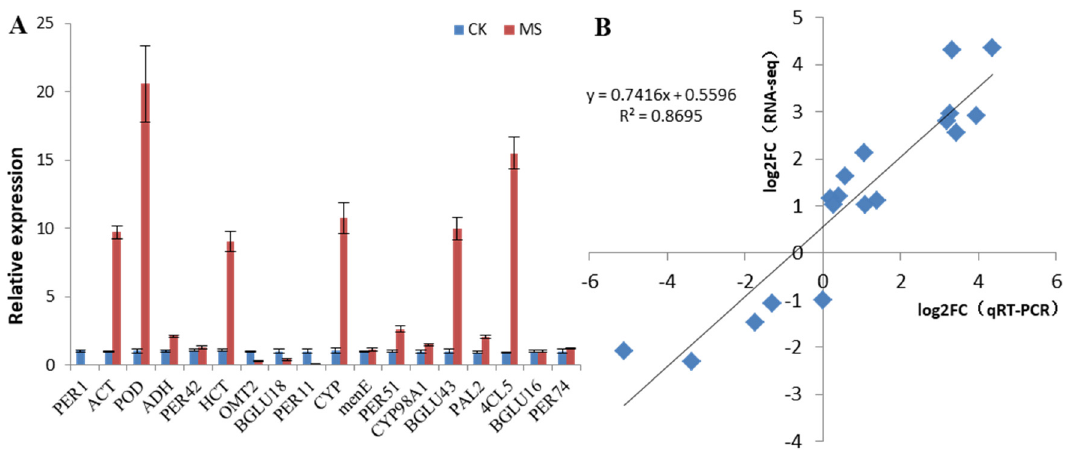
Figure 6. qRT-PCR validation of 18 selected genes. ( A ) Gene expression analysis based on qRT-PCR; ( B ) Pearson correlation analysis between RNA-seq and qRT-PCR expression profiles.